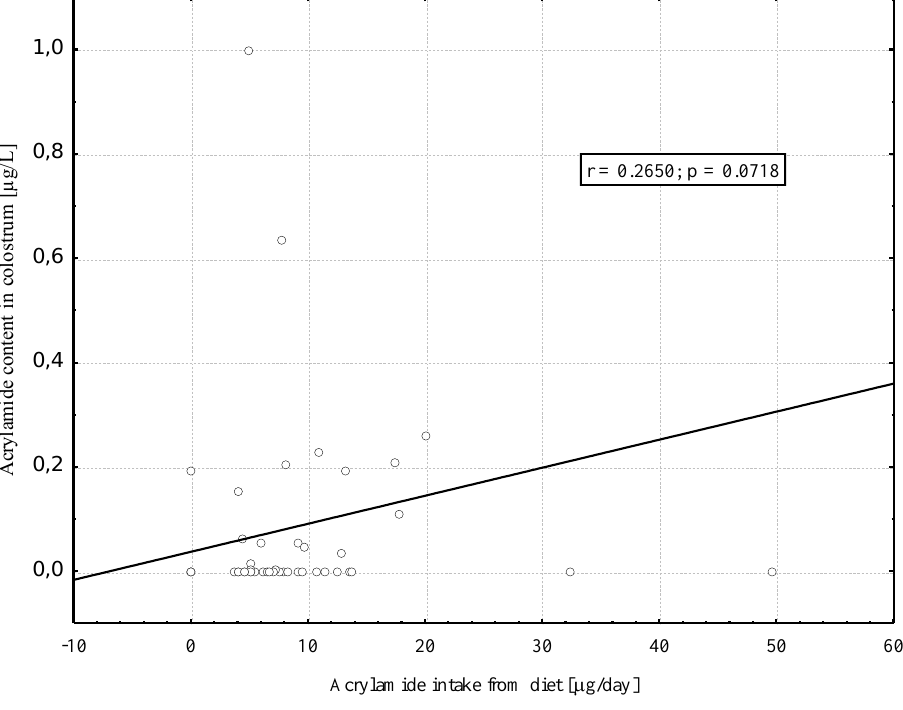
Table 5. Estimated exposure of infants to acrylamide in breast milk and margins of exposure (MOE). Parameter tested